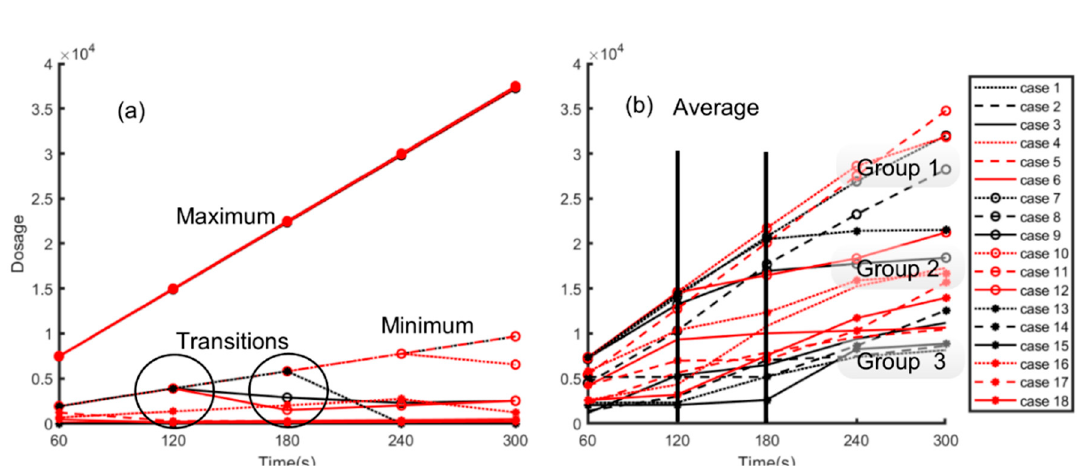
Figure 8. ( a ) Maximum and minimum, and ( b ) average number of particles that an adult is exposed to after a “sneeze” over 300 s or a five-minute period.